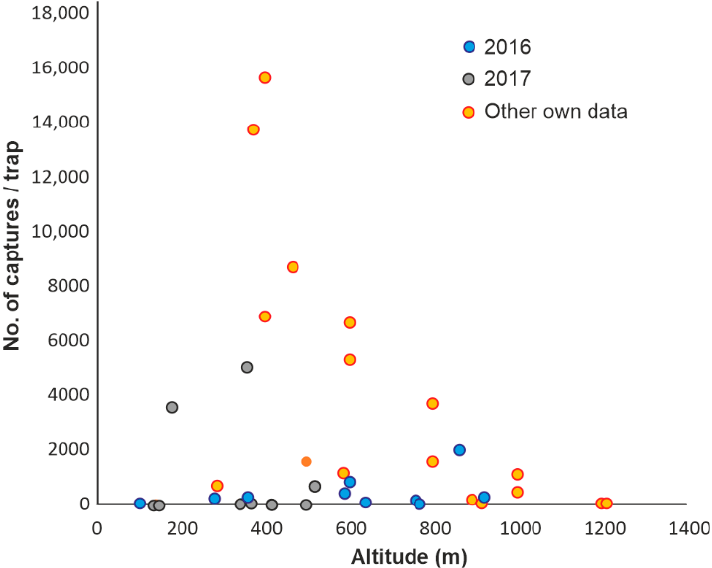
Figure 5. Variation of NBB captures with altitude in different years. Only studies that were carried out throughout the vegetation season and used pheromone lures for NBB were